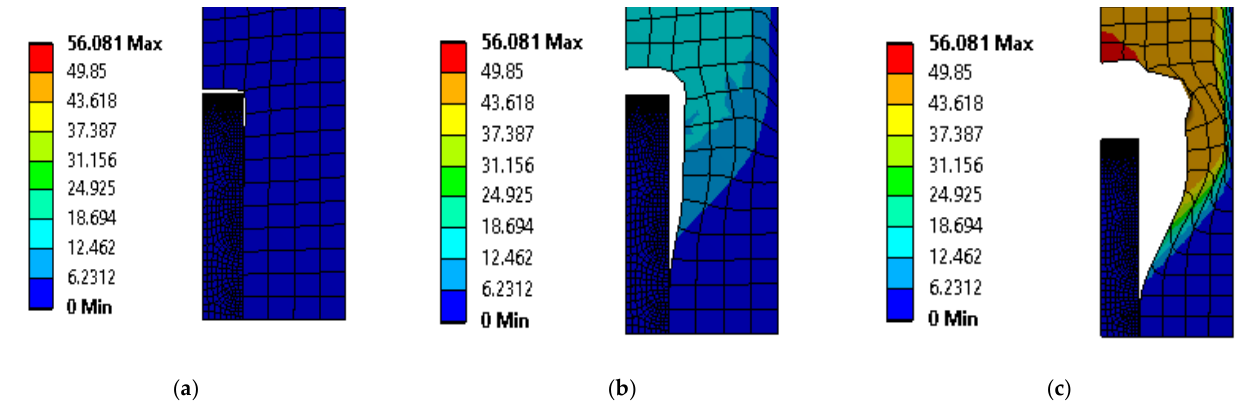
J. Compos. Sci. 2021 , 5 , x FOR PEER REVIEW Figure 7. von Mises stress and displacement fields of the RVE of a PNC reinforced with a rectangle-shaped clay nanoparticle: ( a ) crack initiates, ( b ) crack propagates, and ( c ) crack propagates at the final failure.